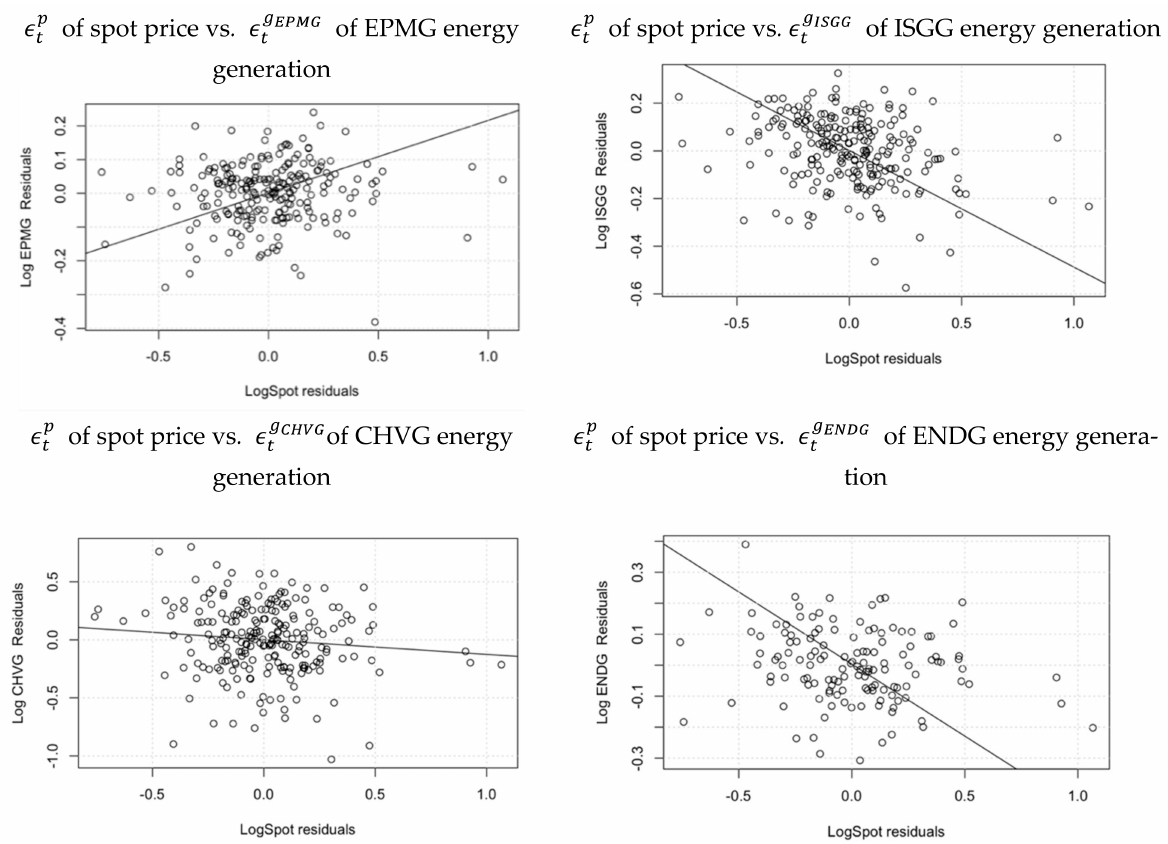
Figure 4. Scatterplots of the residuals of spot price versus those of each energy generation. Linear correlations among the variables is depicted with the fitted